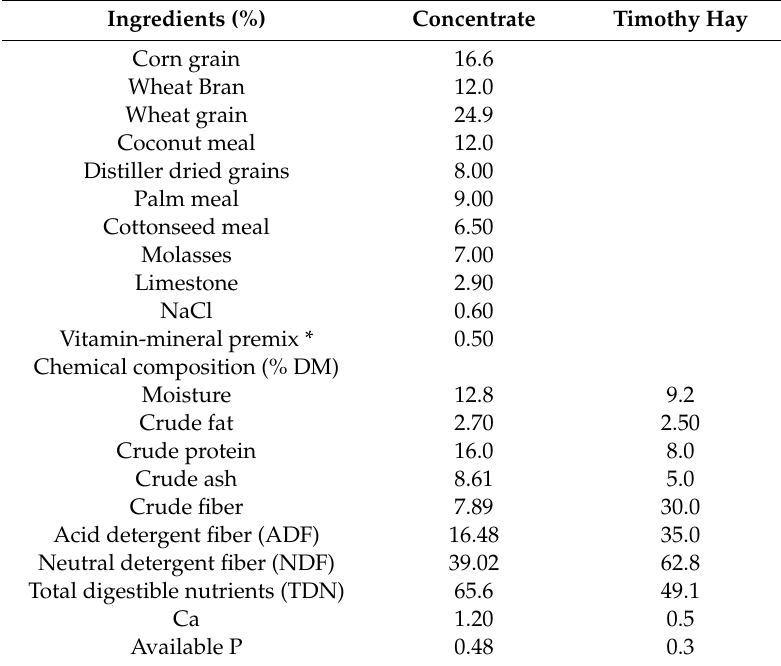
Table 3. Composition (%) of the experimental basal